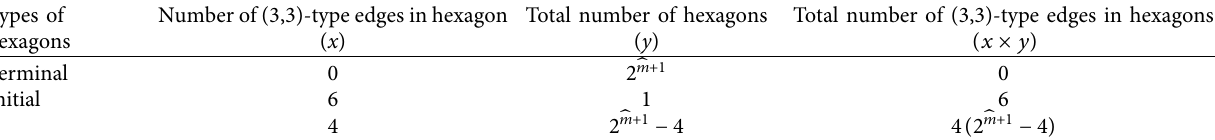
Table 7: The total number of (3,3)-type edges in hexagons of ζ .